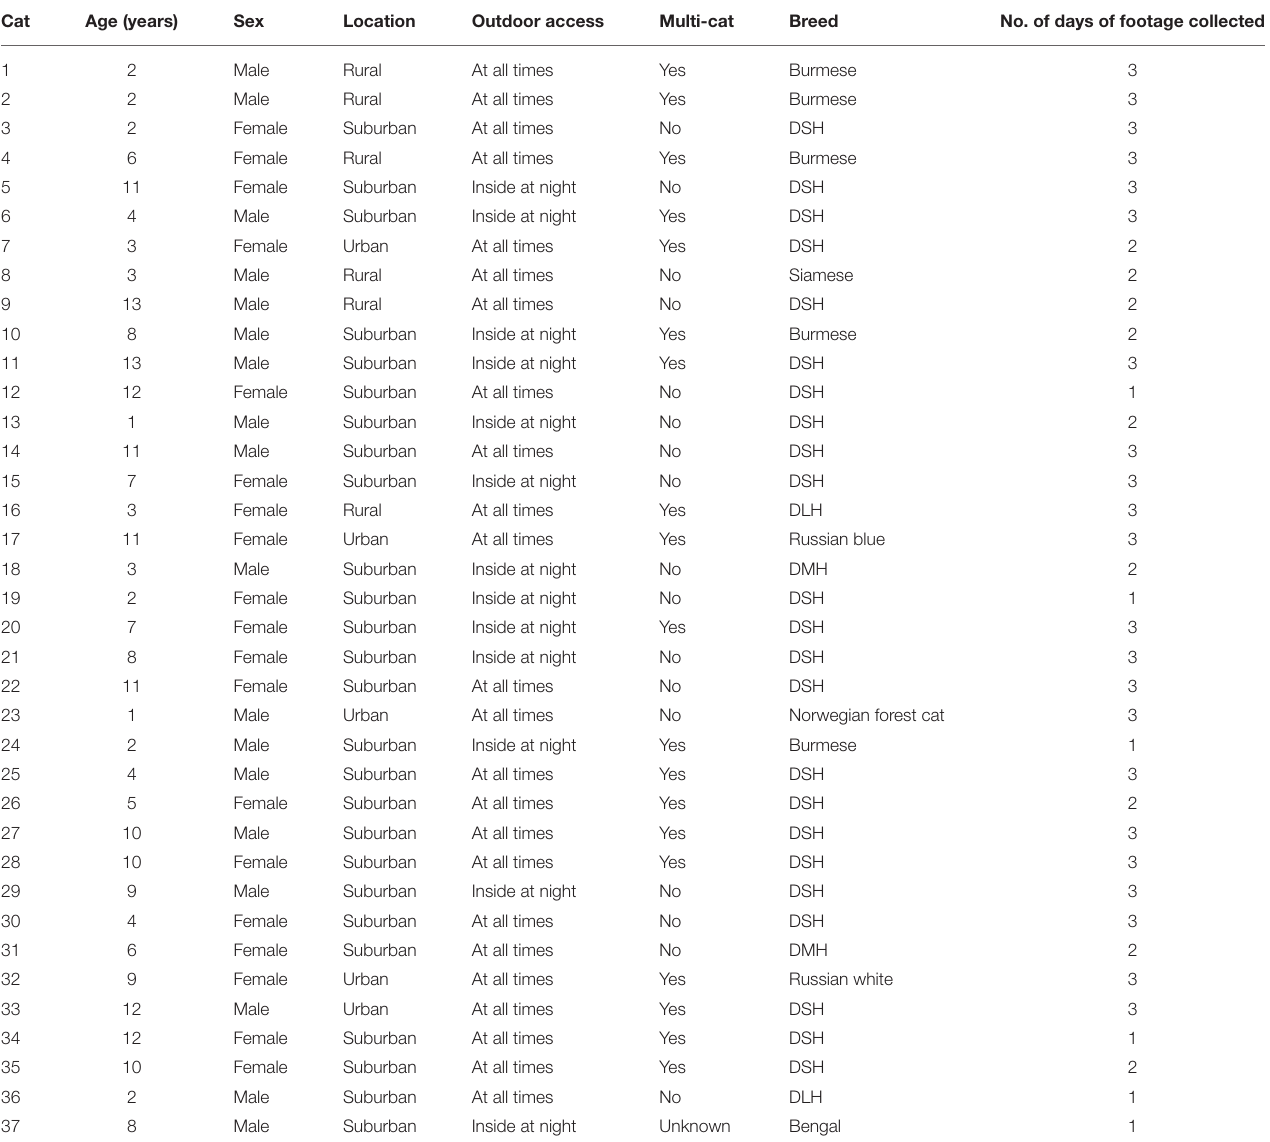
TABLE 2 | Individual cat demographics. Cat Location Outdoor access Multi-cat Breed No. of days of footage collected